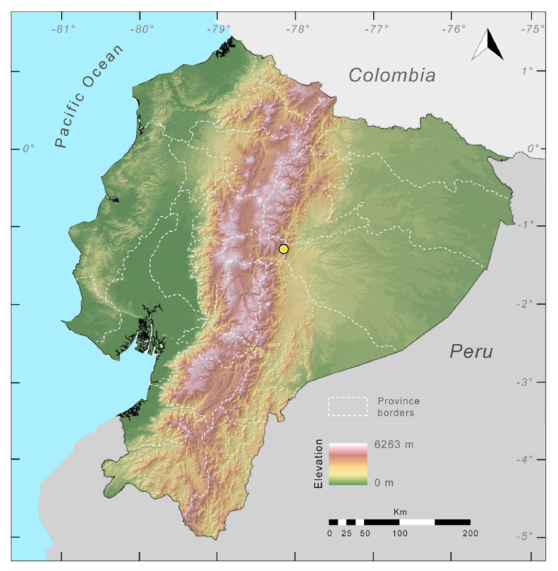
Figure 100. Distribution of Hyalinobatrachium adespinosai in Ecuador (yellow spot). Evolutionary relationships